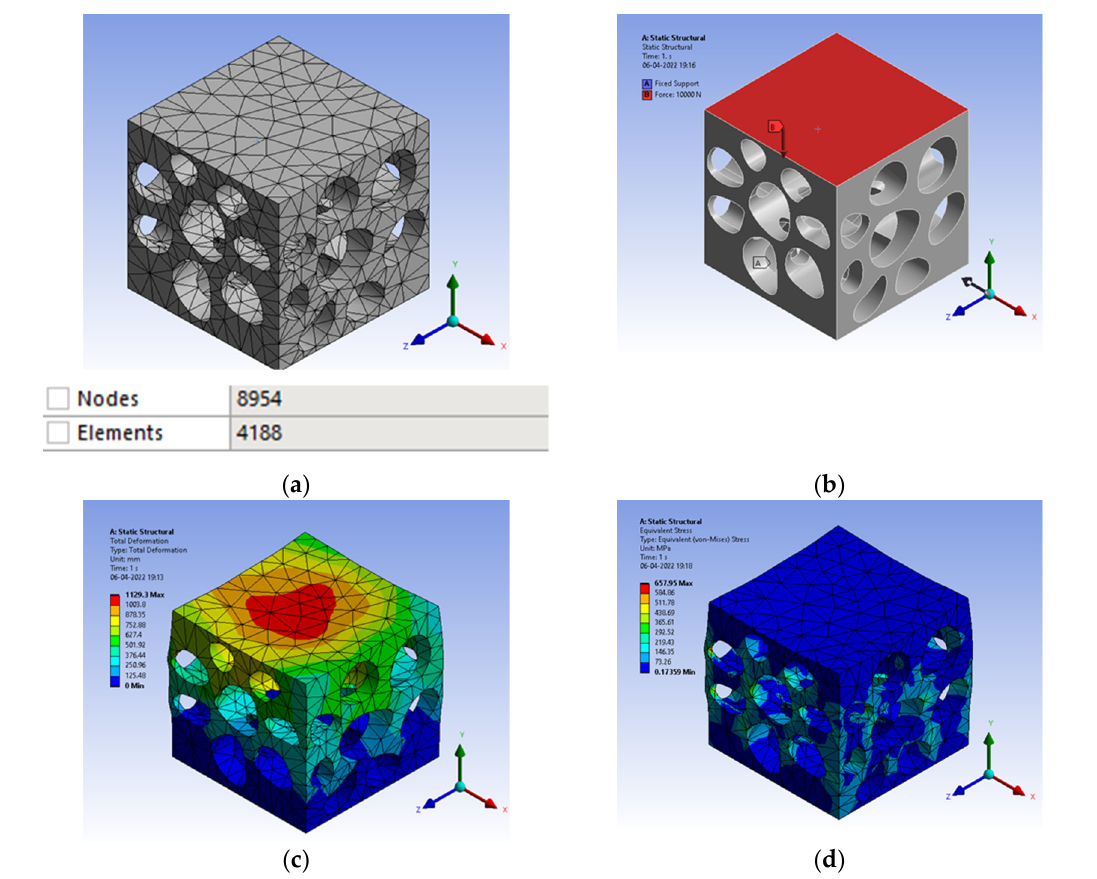
Figure 14. ( a ) Mesh generation; ( b ) Loads and boundary conditions; ( c ) Total deformation; ( d ) Von mises stress.